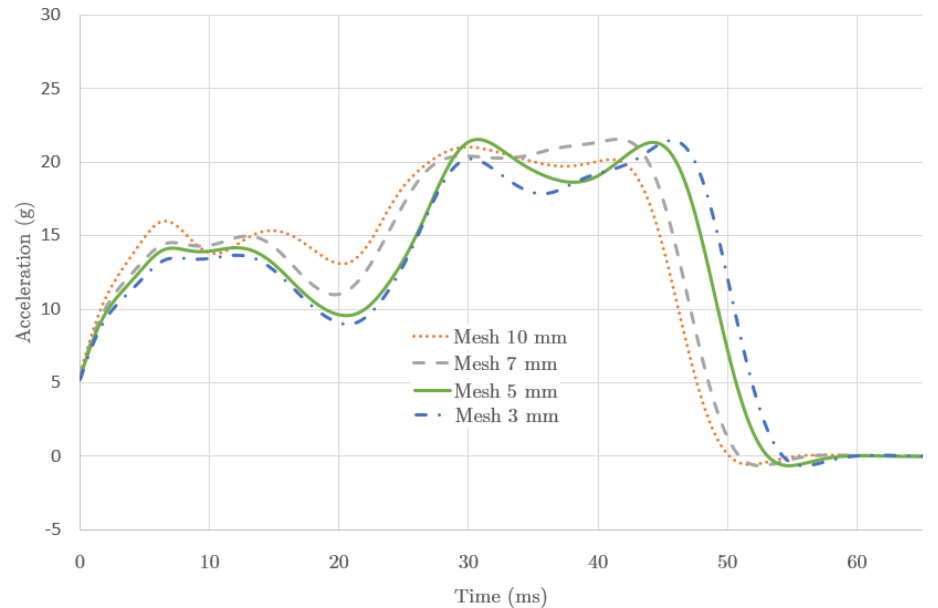
Figure 5. Calculated acceleration (g) as function of the time after impact with mesh sizes set to 10,7,5 and 3 mm (see